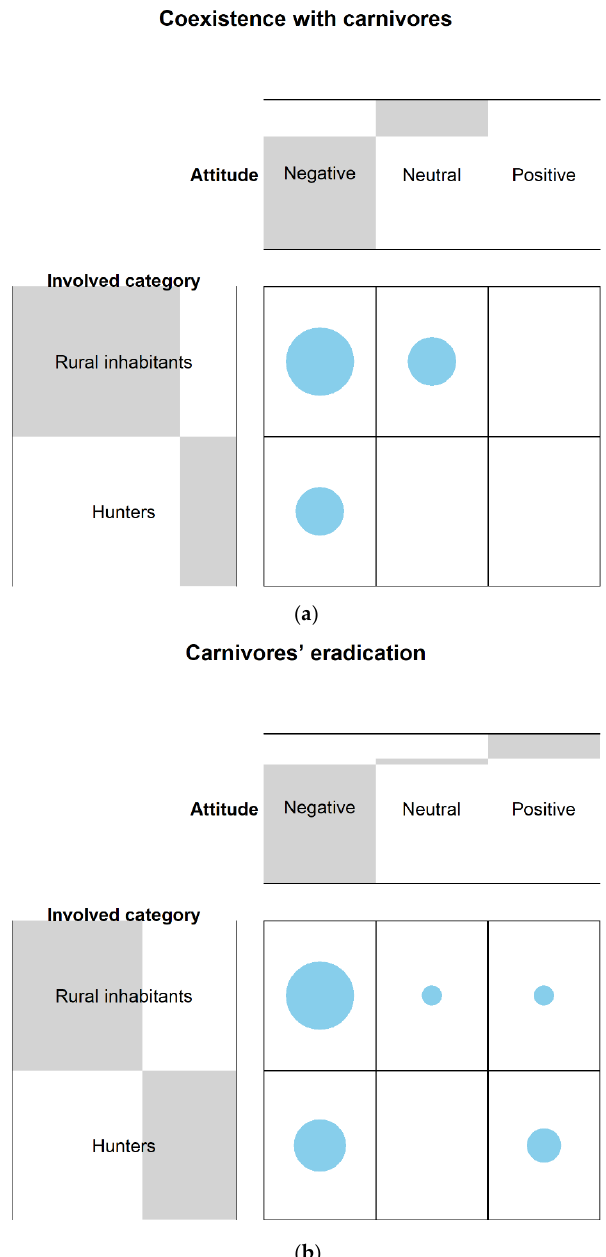
Figure 5. ( a ). Contingency table showing the distribution frequency regarding the attitude towards carnivores of rural inhabitants (mainly farmers and livestock owners) and hunters in areas where humans and carnivores have always coexisted. The size of the grey bars depends on the number of responses obtained by each stakeholder category for each attitude (refer to Figure 3 caption for a more detailed explanation). Reference list: [36,52,66,67]. ( b ) Contingency table showing the distri- bution frequency regarding the attitude towards carnivores of rural inhabitants (mainly farmers and livestock owners) and hunters in areas where carnivores have been eradicated. The size of the grey bars depends on the number of responses obtained by each stakeholder category for each atti- tude (refer to Figure 3 caption for a more detailed explanation). Reference list: [34,39–